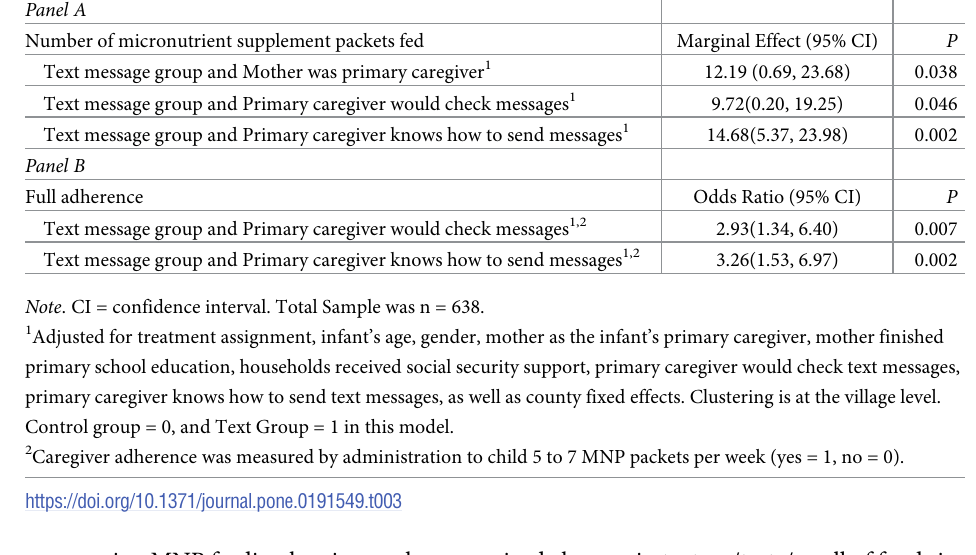
Table 3. Heterogeneous impact of daily text messages: Rural Shaanxi Province, 2013. Panel